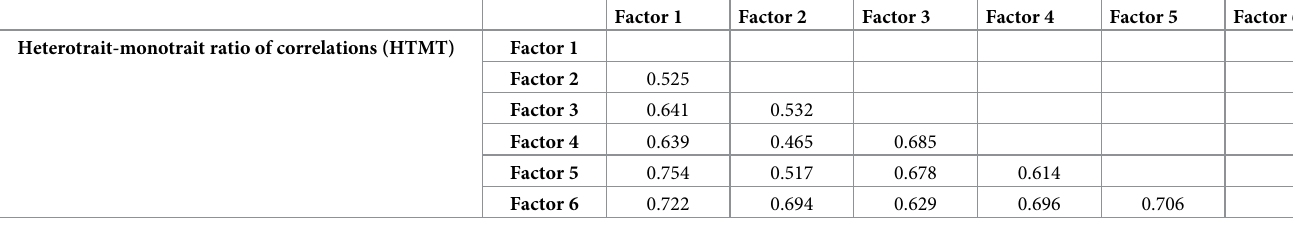
through the linear scoring using the formula stated below: The obtained row score (cid:0) The lowest possible raw score Transformed scale ¼ ð The highest possible raw score (cid:0) The lowest possible raw score Obviously, after converting the scores to the standard values, the higher average score of resilience close to one hundred indicated the higher score of the resilience in nursing students. Table 4. Discriminant validity assessment using the HTMT